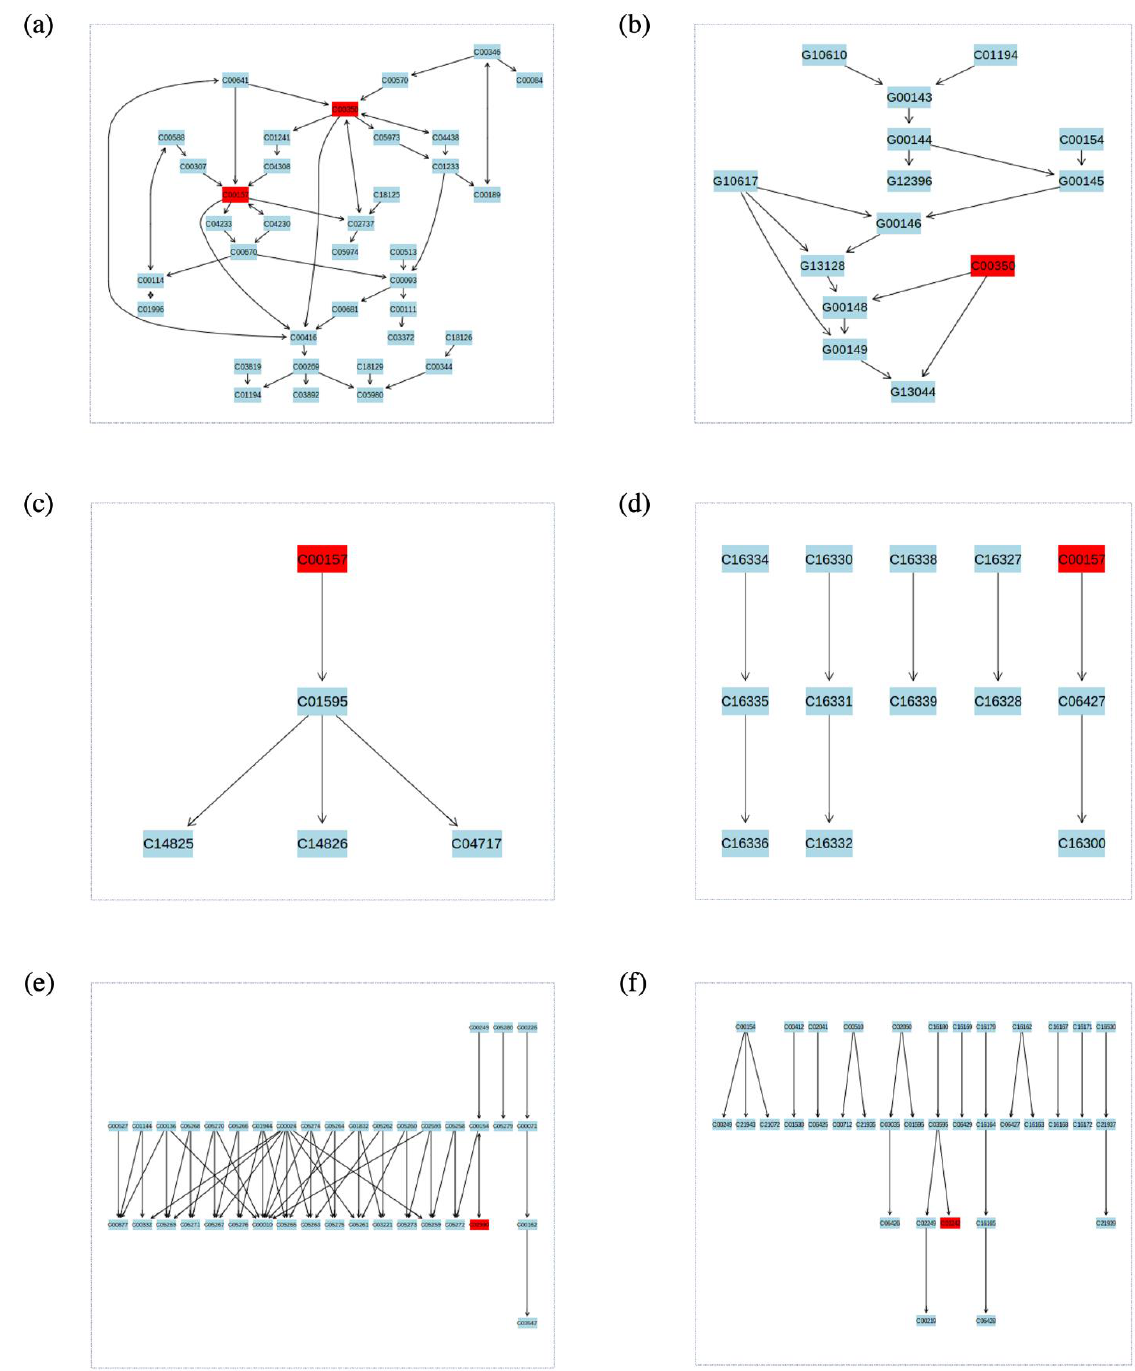
Figure 6. Enrichment analysis performed with identified metabolites for endo- and exometabolome, each one represents a significant metabolic pathway ( a ) Glycerophospholipid metabolism ( b ) Gly- cosylphosphatidylinositol (GPI) biosynthesis ( c ) Linoleic acid metabolism ( d ) alpha-Linolenic acid metabolism ( e ) Fatty acid degradation ( f ) Biosynthesis of unsaturated fatty acids. In red, metabolites identified with the analysis was highlighted. C00157 is phosphatidylcholine or lecithin; C00350 is (3-Phosphatidyl) ethanolamine; C02990 is L-Palmitoylcarnitine and C03242 is Dihomo-gamma-lin- olenate.